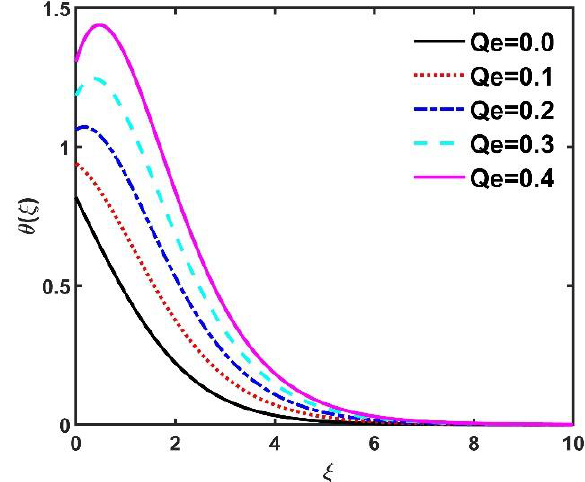
Figure 21. Impact of 𝑄𝑒 on 𝜃(𝜉) .